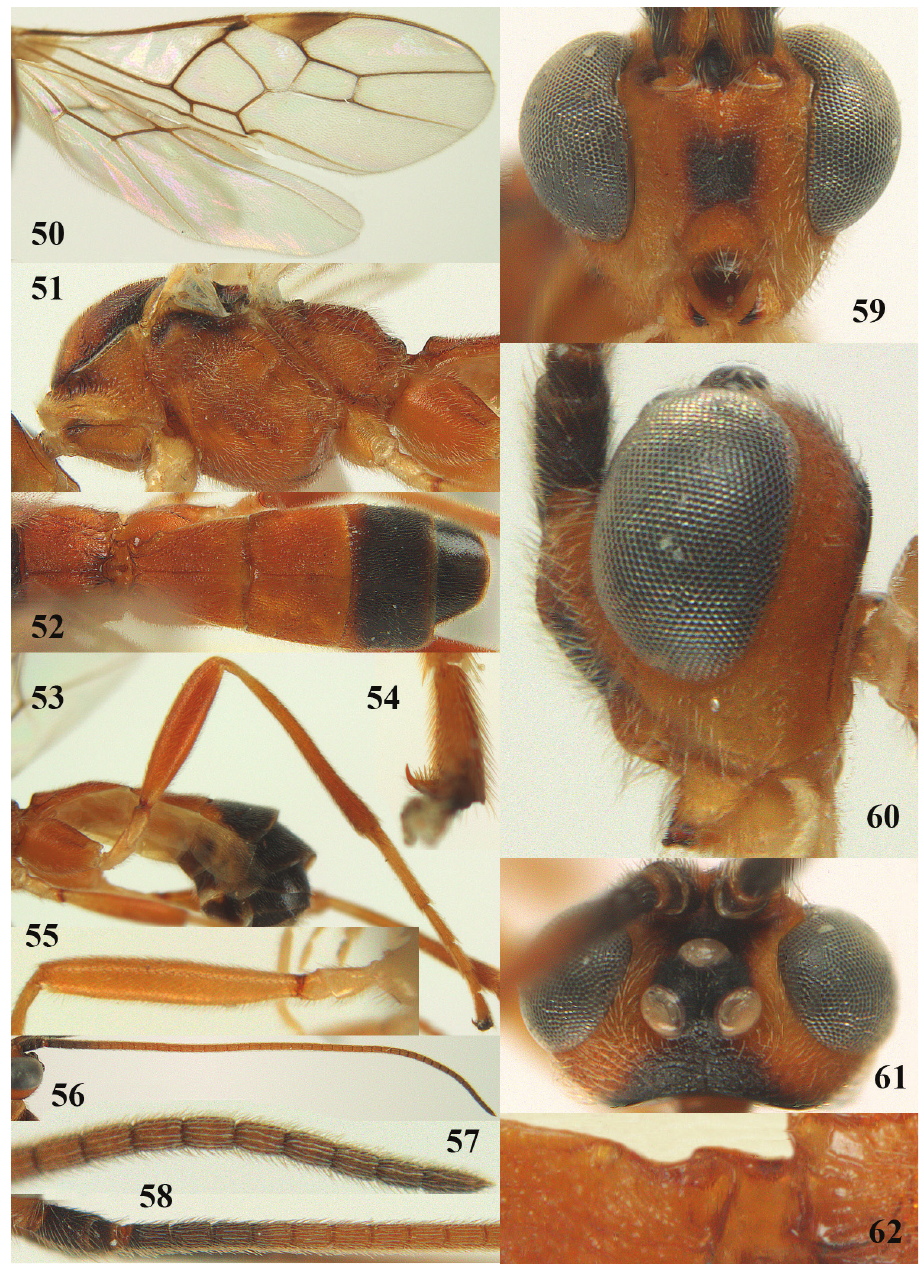
deum and anterior half of metasoma dorsal 53 hind leg lateral 54 outer hind claw lateral 55 fore femur lateral 56 antenna 57 apical segments of antenna 58 basal segments of antenna 59 head anterior 60 head lateral 61 head dorsal 62 base of first tergite